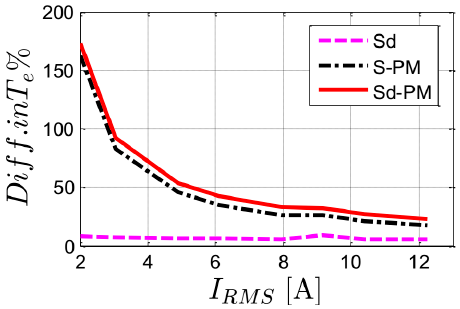
Figure 9. Difference in the output torque % ( T e ) as a function of stator current ( RMS ) with respect to the S machine at the optimal current angles and rated speed of the SynRMs.